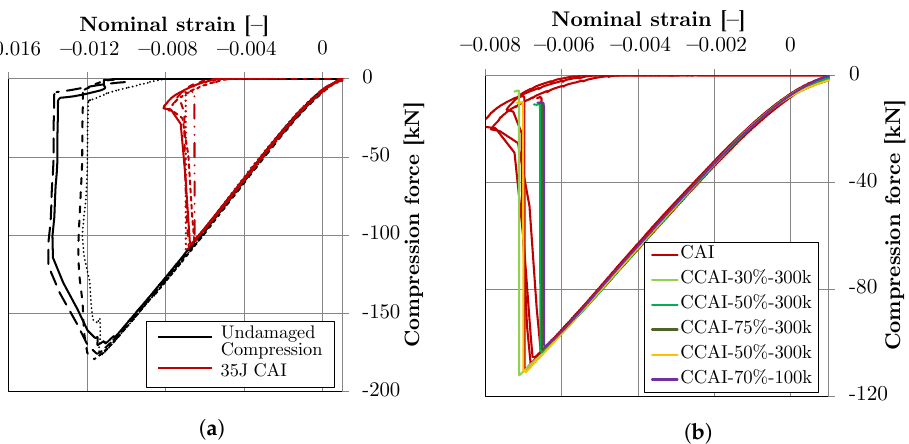
Figure 6. Force-strain history of the compression tests with the virgin specimens, the impacted CAI specimens, and the CCAI specimens with a cyclic load history. ( a ) Compression and CAI specimens. ( b ) CAI and CCAI